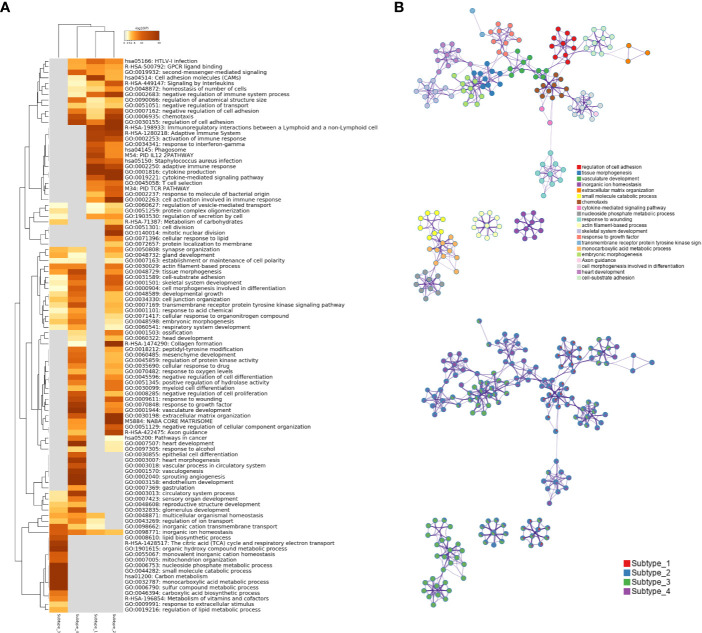

(A) Statistically enriched terms were identified and then hierarchically clustered into a tree based on Kappa-statistical similarities among their gene memberships. The heatmap cells are colored by their p-values; white cells indicate the lack of enrichment for that term in the corresponding gene list. (B) A subset of representative terms from the full cluster was selected and converted into a network layout. Each term is represented by a circle node, where its size is proportional to the number of genes satisfying that term and its color represents its cluster identity. Terms with a similarity score > 0.3 are linked by an edge where the thickness of the edge indicates the magnitude of similarity. The same enrichment network has its nodes displayed as pies. Each pie sector is proportional to the number of hits originated from a gene list.